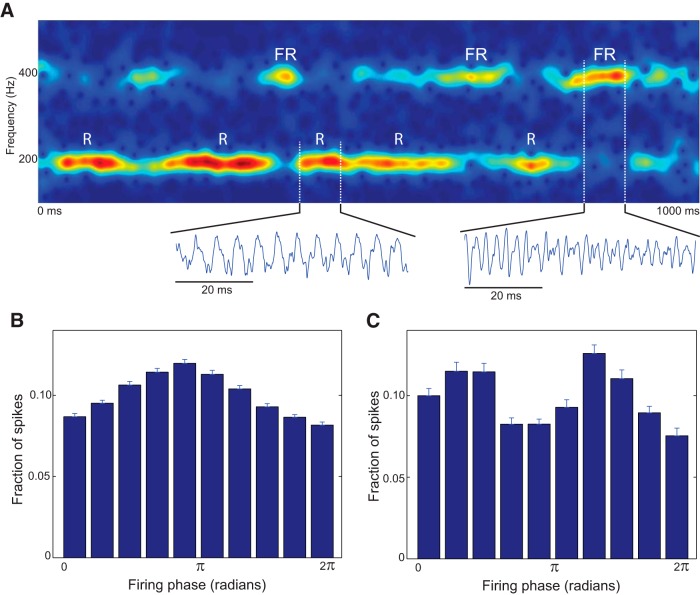
Emergence of fast ripples in an uncoupled, asynchronously spiking network. Using the same parameters as the highest-frequency data in Figure 6, a 20,000 ms simulation was performed to identify the emergence of HFOs in a network of 80 uncoupled pyramidal cells driven by high levels of uncorrelated noisy input. A, LFP spectrogram of a 1000 ms interval demonstrates that both ripple (R) and fast ripple (FR) episodes emerged sporadically. B, Spike-timing histogram relative to ripple phase, averaged over all 78 observed ripple episodes. C, Spike-timing histogram relative to ripple phase, averaged over all 26 observed fast ripple episodes. Ripples occurred when the 80 cells achieved brief unimodal spike time distribution, and fast ripples occurred when the distribution was transiently bimodal. Error bars represent SEM over all observed ripple/fast ripple episodes.